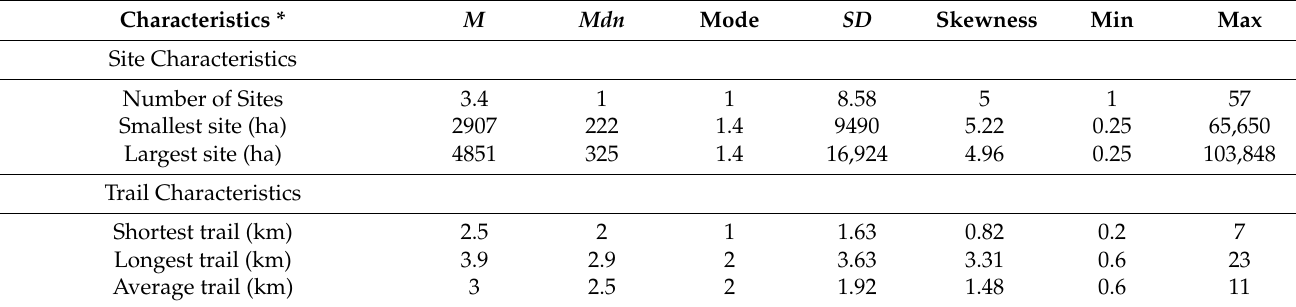
Table 3. Statistical summary of site and trail characteristics for the article